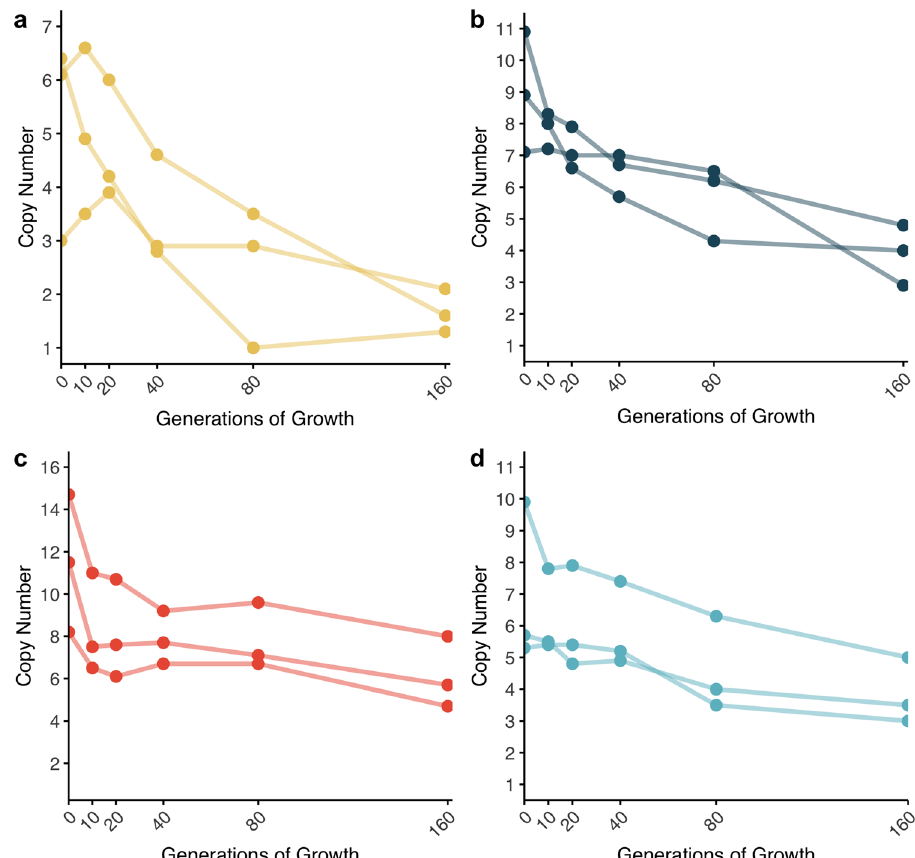
Fig. 4 Gene copy number reduction as a function of time for mutants with ampli fi cations grown in the absence of antibiotic. a Tobramycin-resistant E. coli (DA69068-70), b tetracycline-resistant S . Typhimurium (DA69071-73), c cefepime-resistant S . Typhimurium ( DA69074-76), and d piperacillin- tazobactam resistant E. coli (DA69077-79). For each antibiotic and strain, three independent clones were examined (see Table 1). Determination of copy numbers was based on 1 biological and 1 technical replicates ( n =